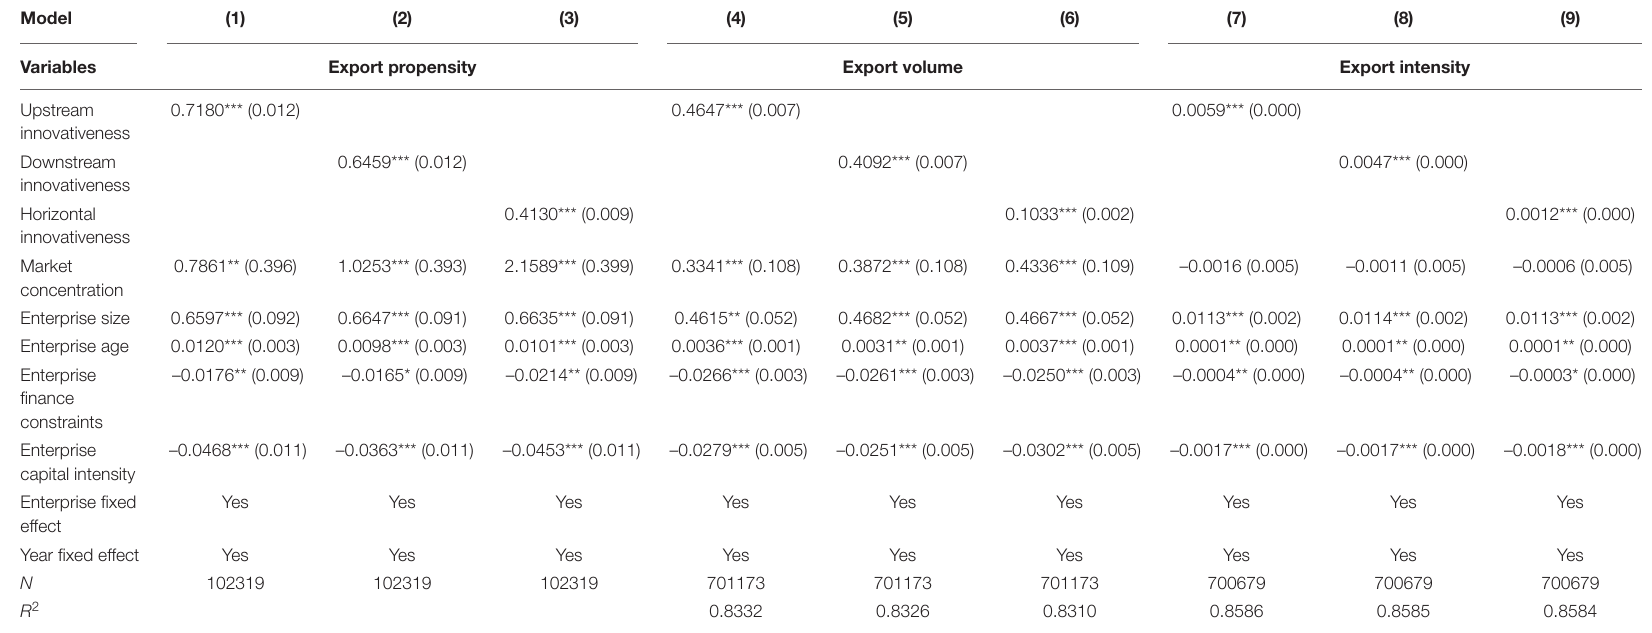
TABLE 1 | Regression results of upstream, downstream, and horizontal innovation on exports of private enterprises.